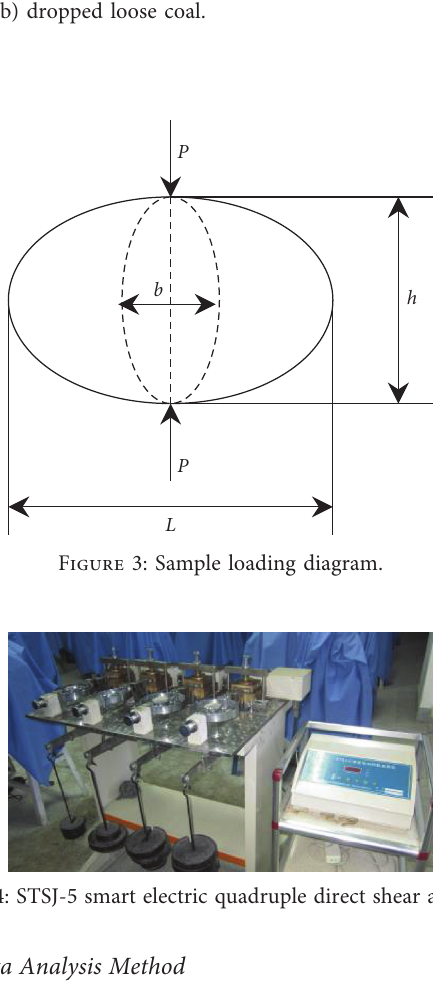
Figure 1: State of coal seam: (a) coal wall; (b) dropped loose coal.